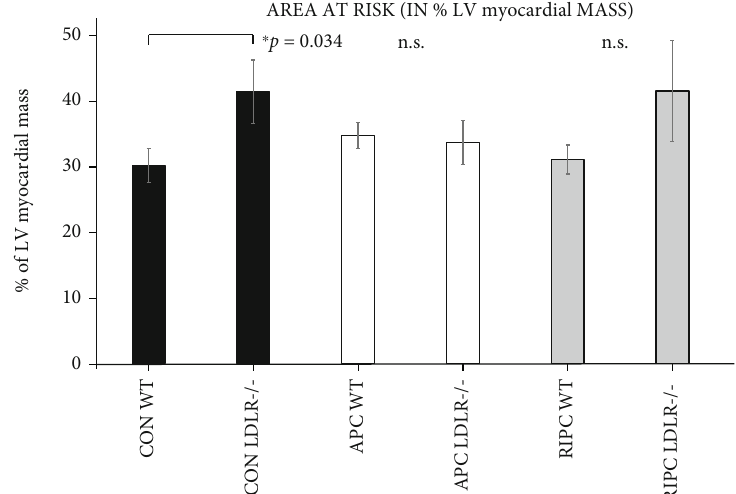
Figure 3: Area at risk in % of the left ventricular area of WT and LDLR-/- mice. Although there is a tendency that LDLR-/- mice have a higher AAR, a signi fi cant di ff erence could only be shown in the control group.